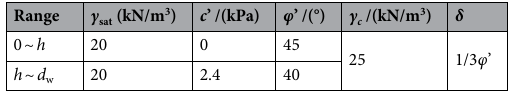
Table 1. Properties of soil and concrete material.